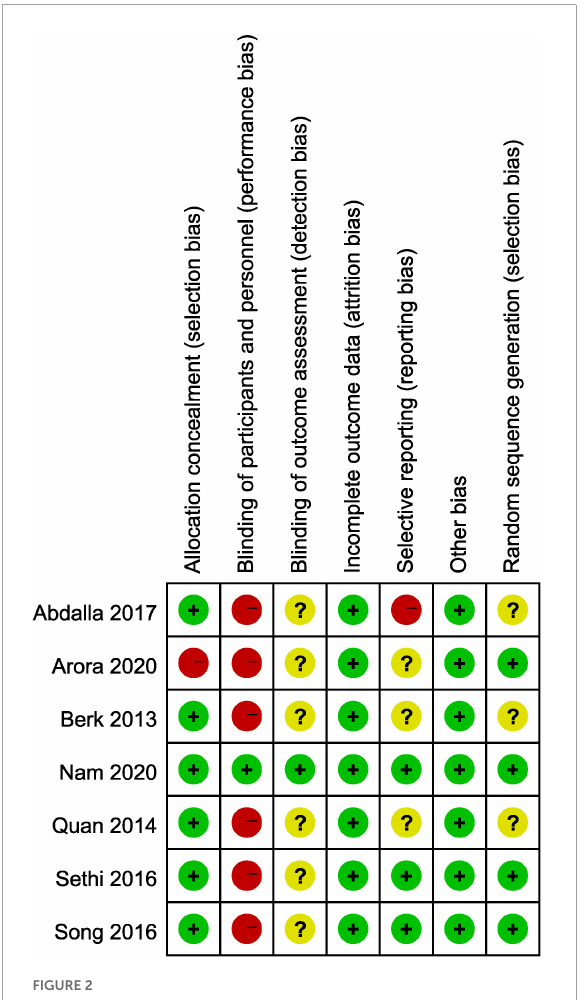
FIGURE2 Summary of risk of